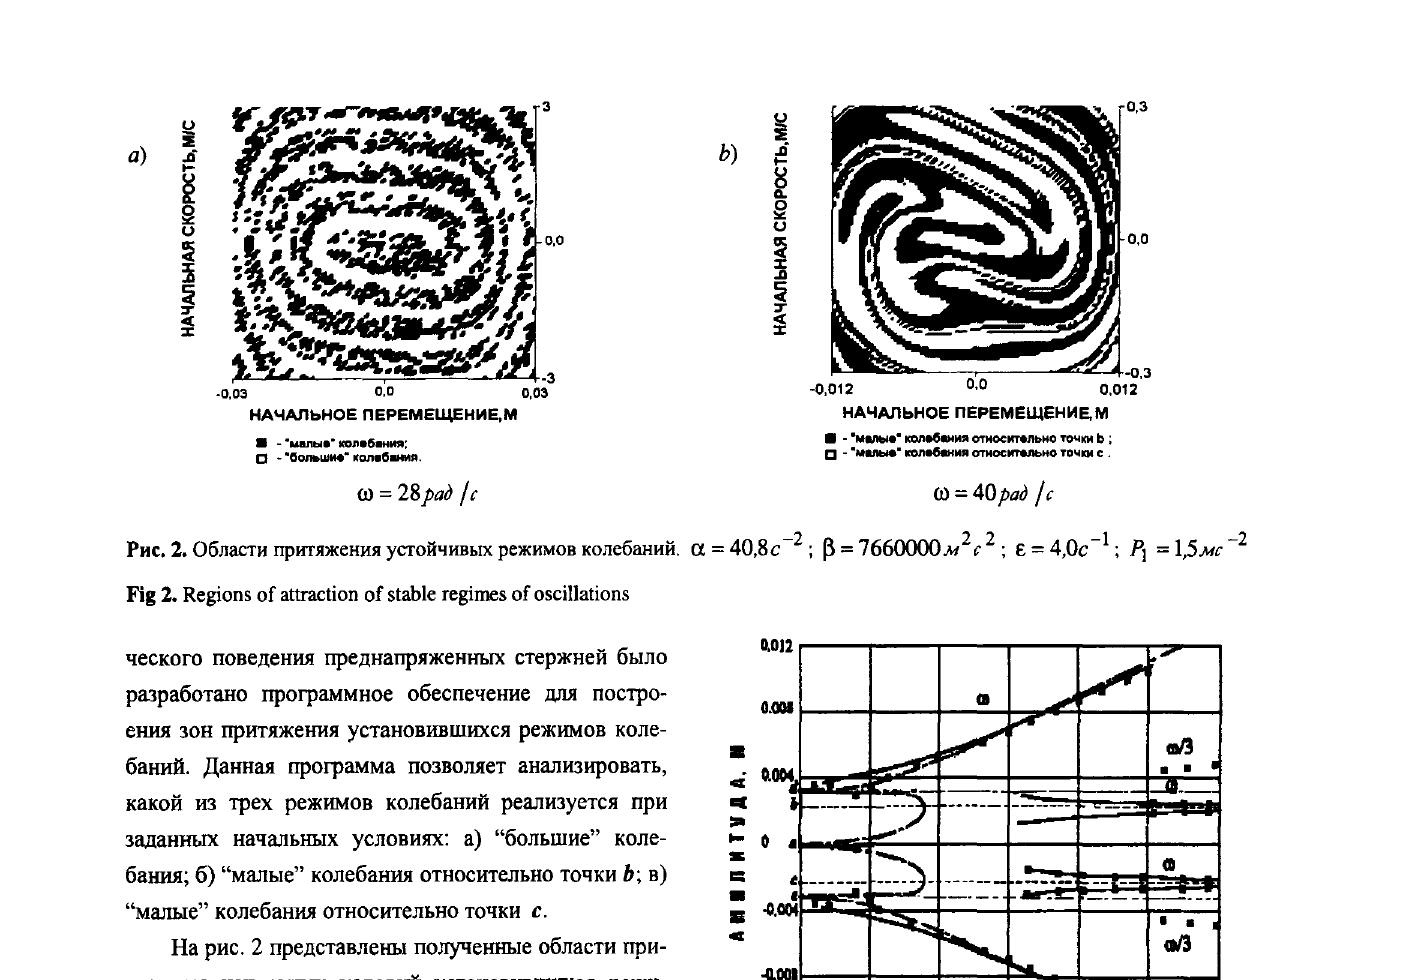
qecKoro rroseneHIDI rrpenHarrpJilKeHH!.IX cTeplKHeH 6Lwo pa3pa6oTaHO rrporpaMMHoe o6ecrre'leHHe .!I,JUI rroCTJlO· eHIDI 30H IIpHTJllKeHHJI ycTaHOBHBlllHXC.!I pe)J<HMOB KOJie- 6amfit .LJ.aHHaJI IIpOrpaMMa II03BOJl.!leT aHaJIH3HpOBaTh,